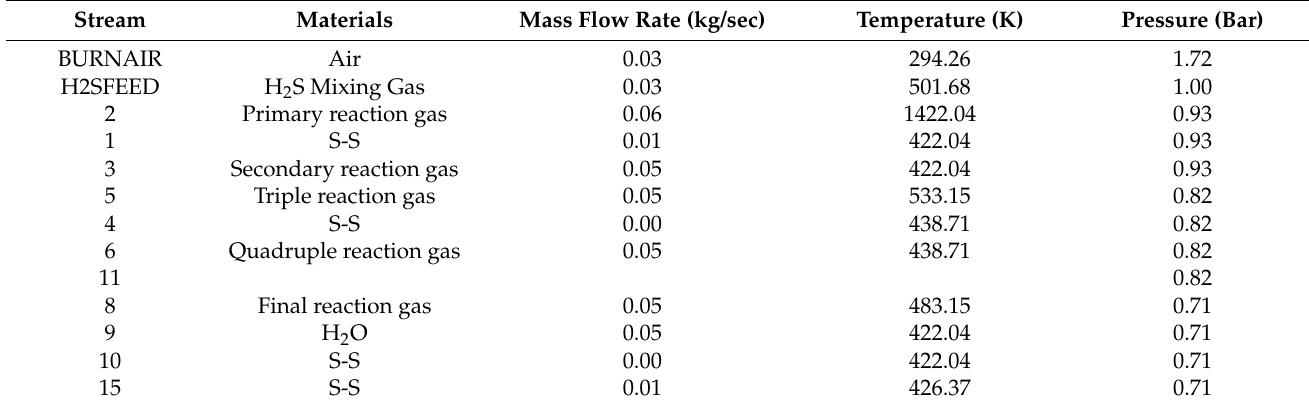
Table 4. Stream parameters in CLAUS.